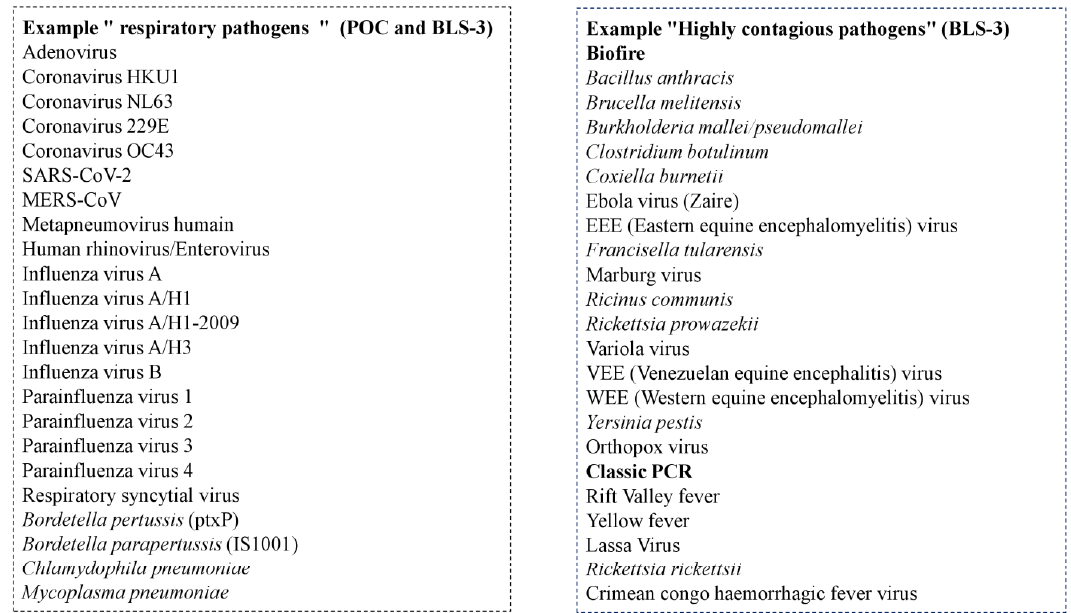
Figure 2. Examples of the large panel of microorganisms tested at the IHU.